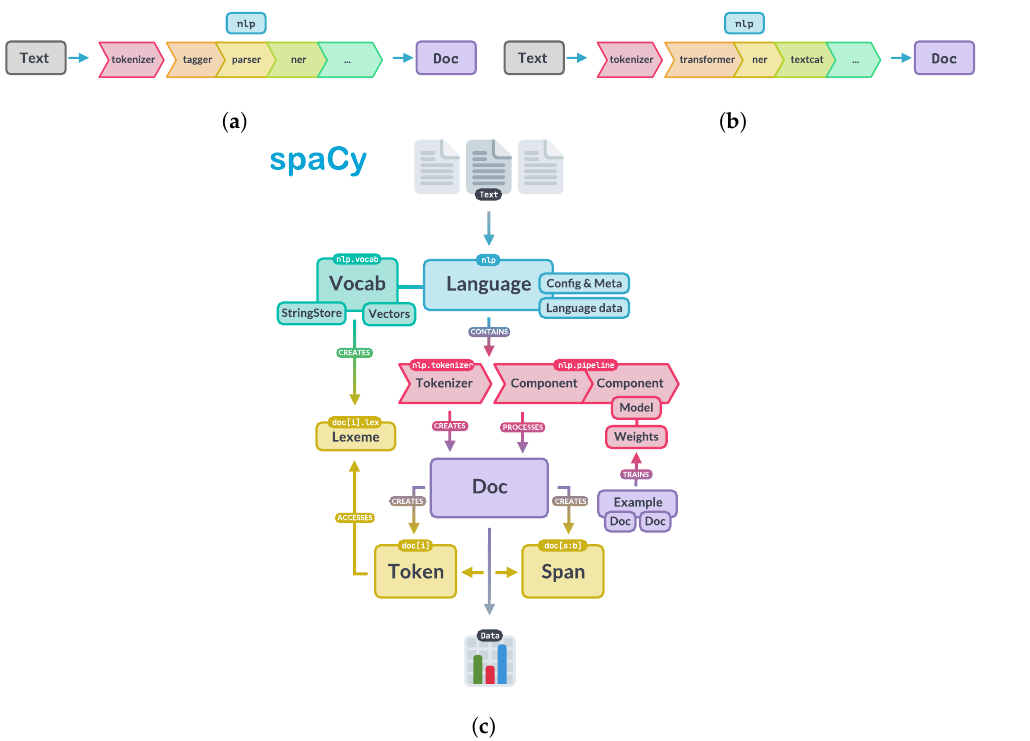
Figure 3. Visual schema for the spaCy models. From [19]. ( a ) spaCy CNN model pipeline. ( b ) spaCy transformer model pipeline. ( c ) Generic spaCy